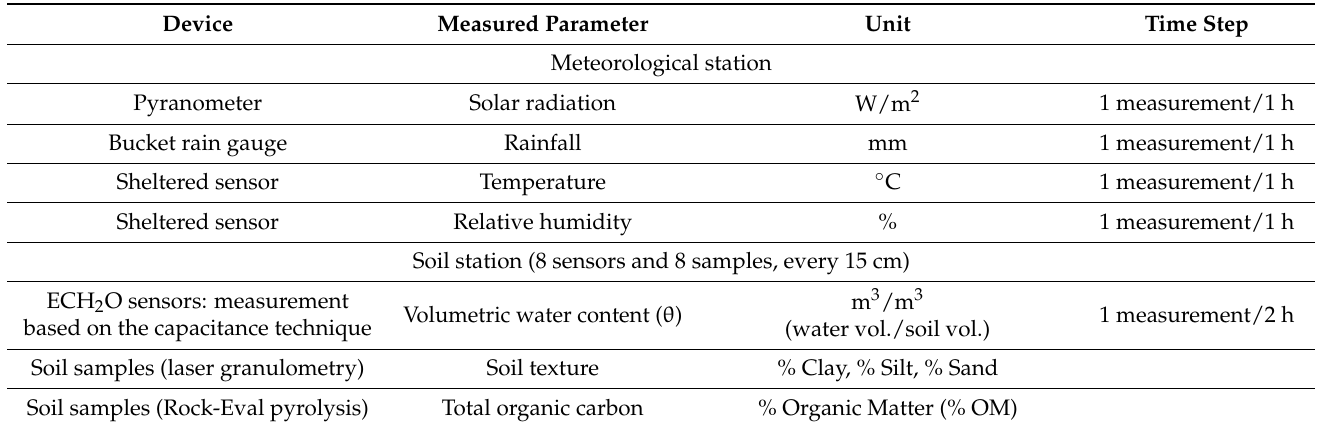
Table 1. Devices installed on the measurement stations, measured parameters, units and chosen time